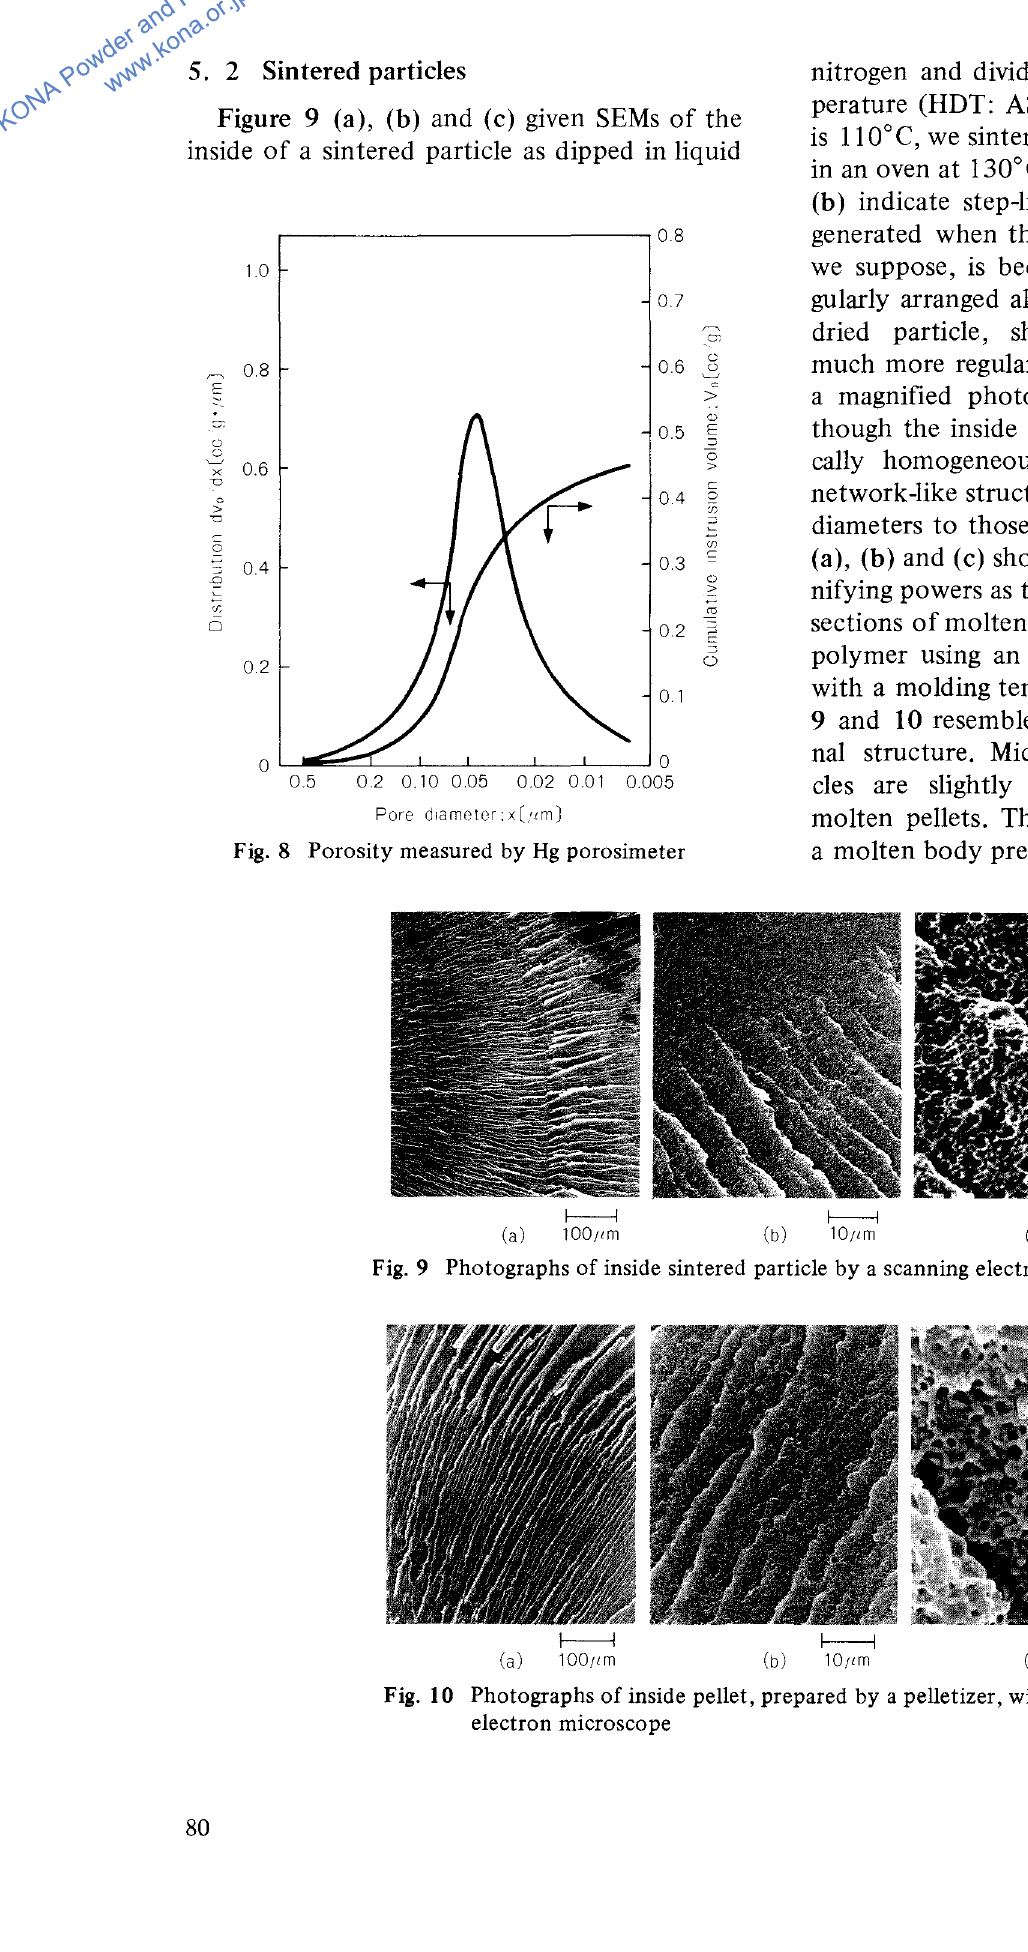
Fig. 8 Porosity measured by Hg porosimeter